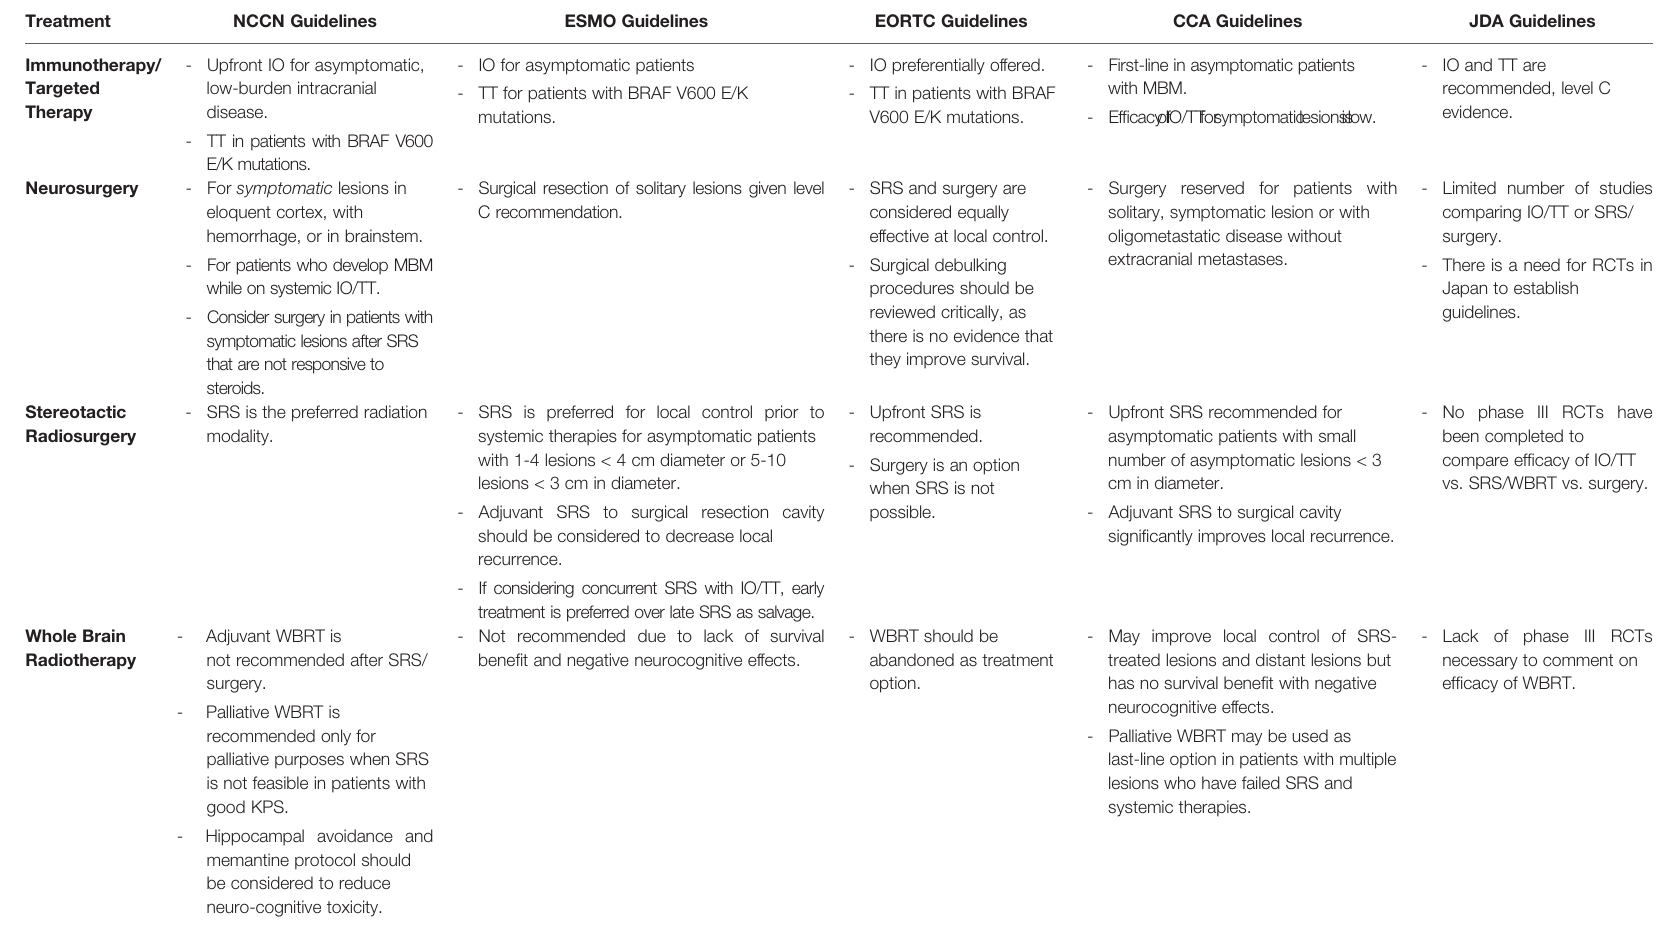
TABLE 1 | Summary of published world guidelines for the treatment of melanoma brain metastases.